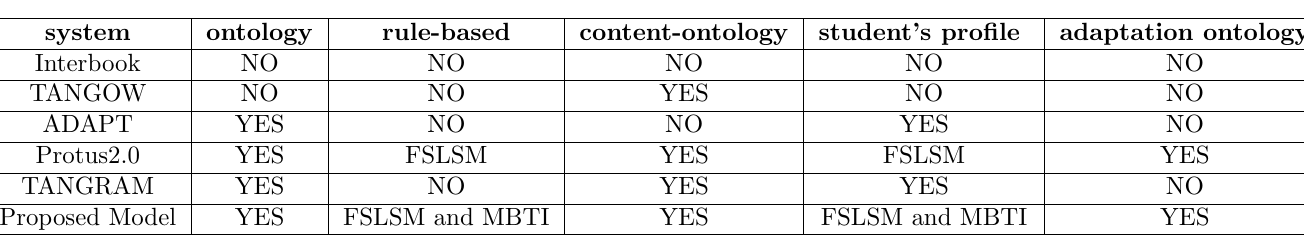
Table 5. compare our proposed model with exiting adaptive